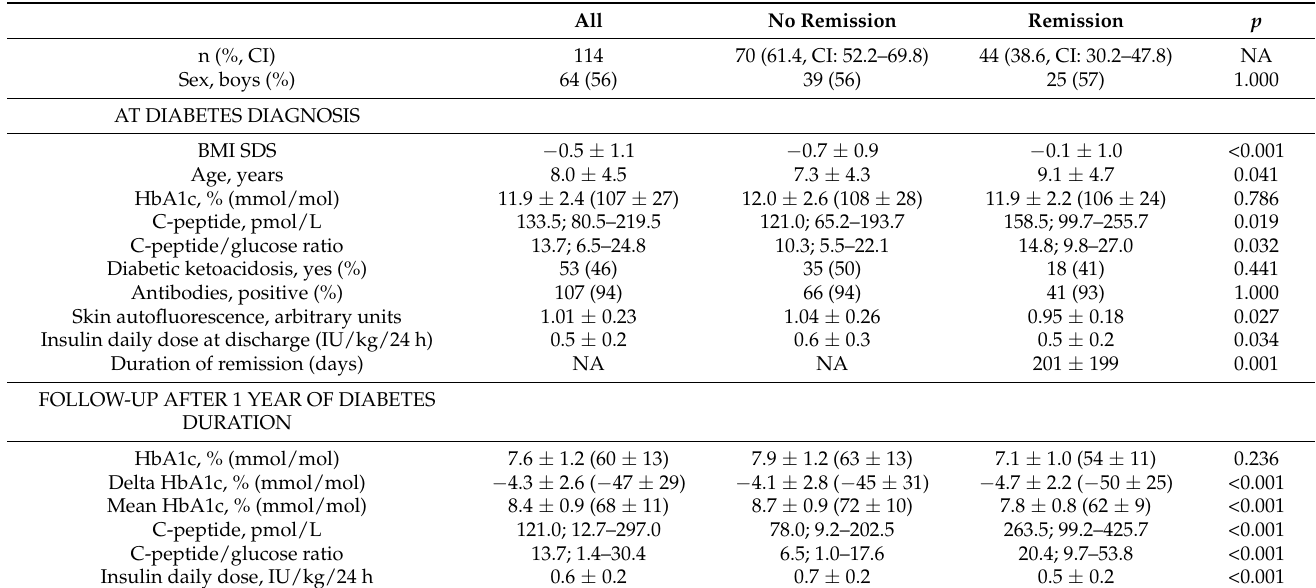
Table 1. Basic characterization of children and adolescents with newly diagnosed T1D and compari- son between remitters and